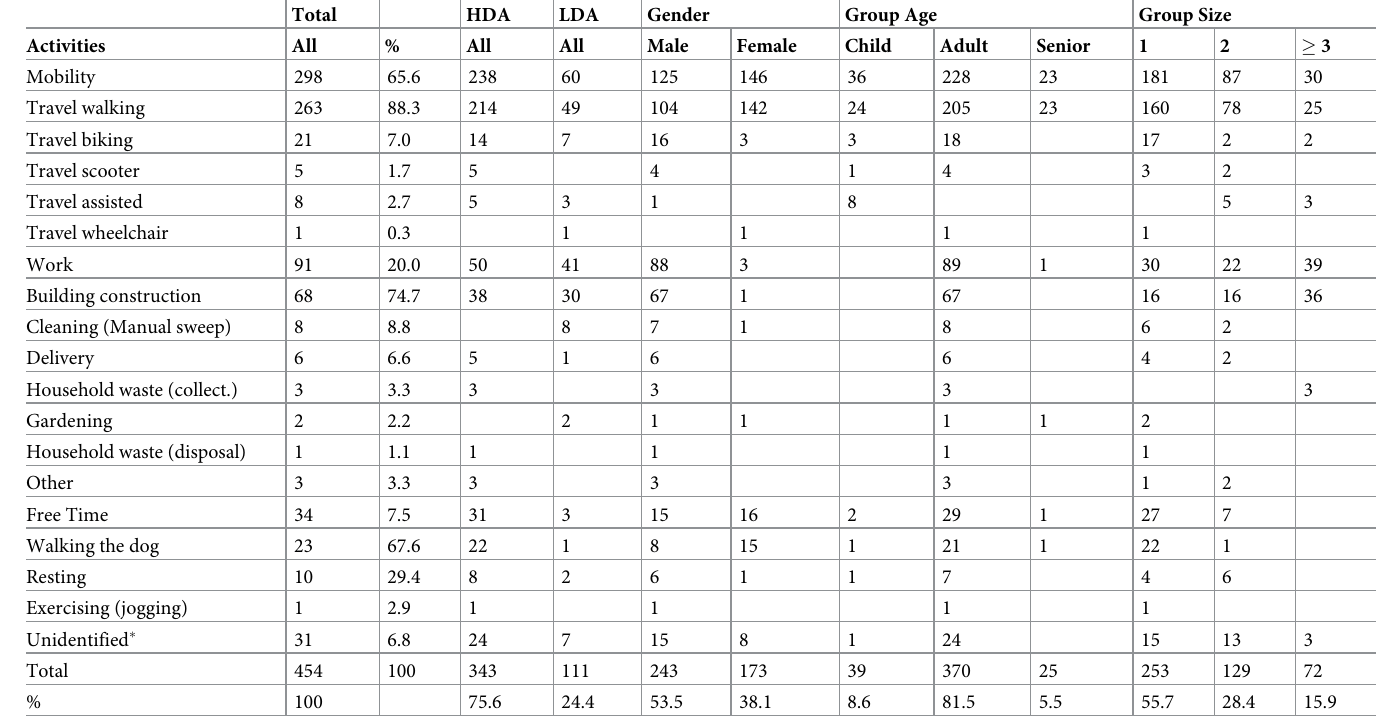
Table 2. Observed activities, gender, group age, and group